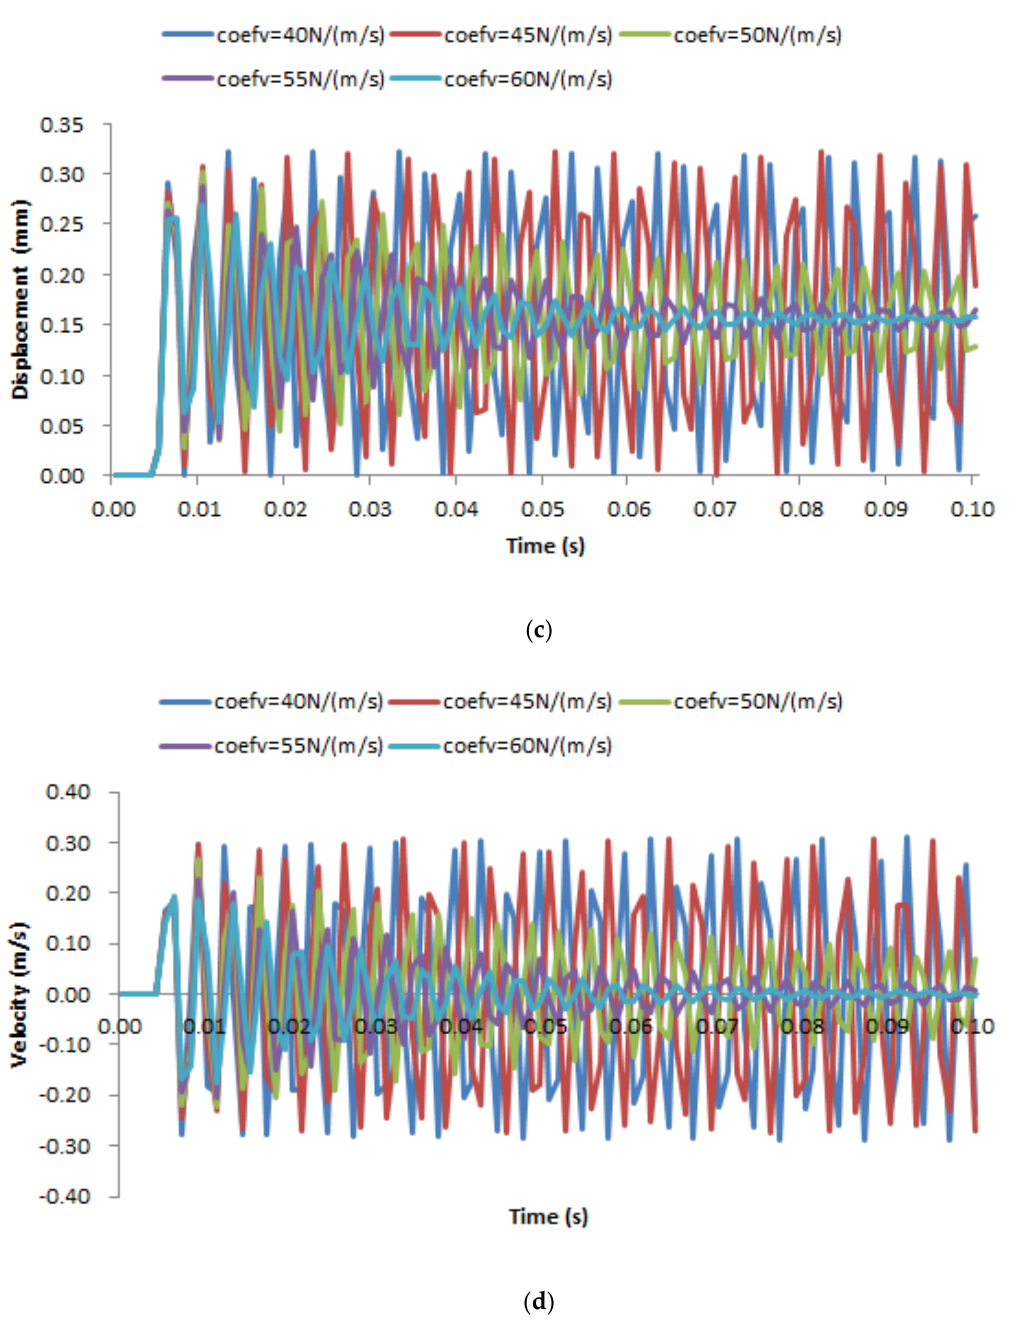
Figure 11. ( a ) The pressure response characteristics — viscosity coefficient: 40~60 N/(m/s). ( b ) The flowrate response characteristics — viscosity coefficient: 40~60 N/(m/s). ( c ) The displacement re- sponse characteristics of the valve element — viscosity coefficient: 40~60 N/(m/s). ( d ) The velocity response characteristics of the valve element — viscosity coefficient: 40~60 N/(m/s).